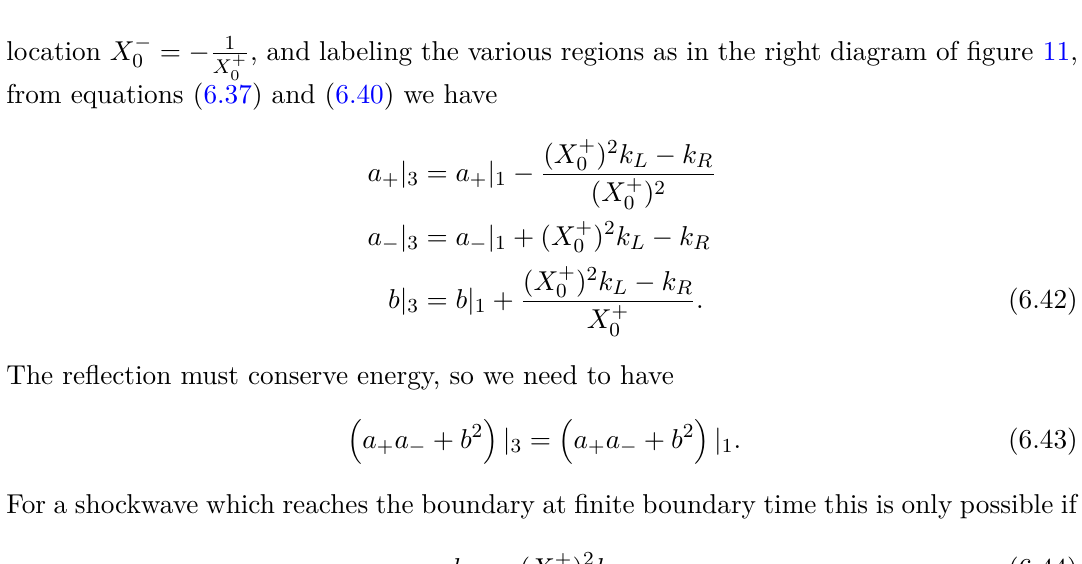
Figure 11 . Labeling the regions in the vicinity of a collision of two shock waves and the reflection of a shock wave off of the left AdS